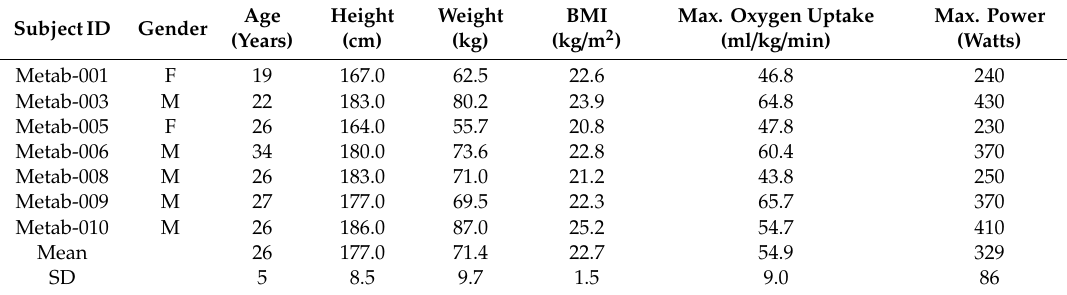
Table 1. Participant information including means and standard deviations for each